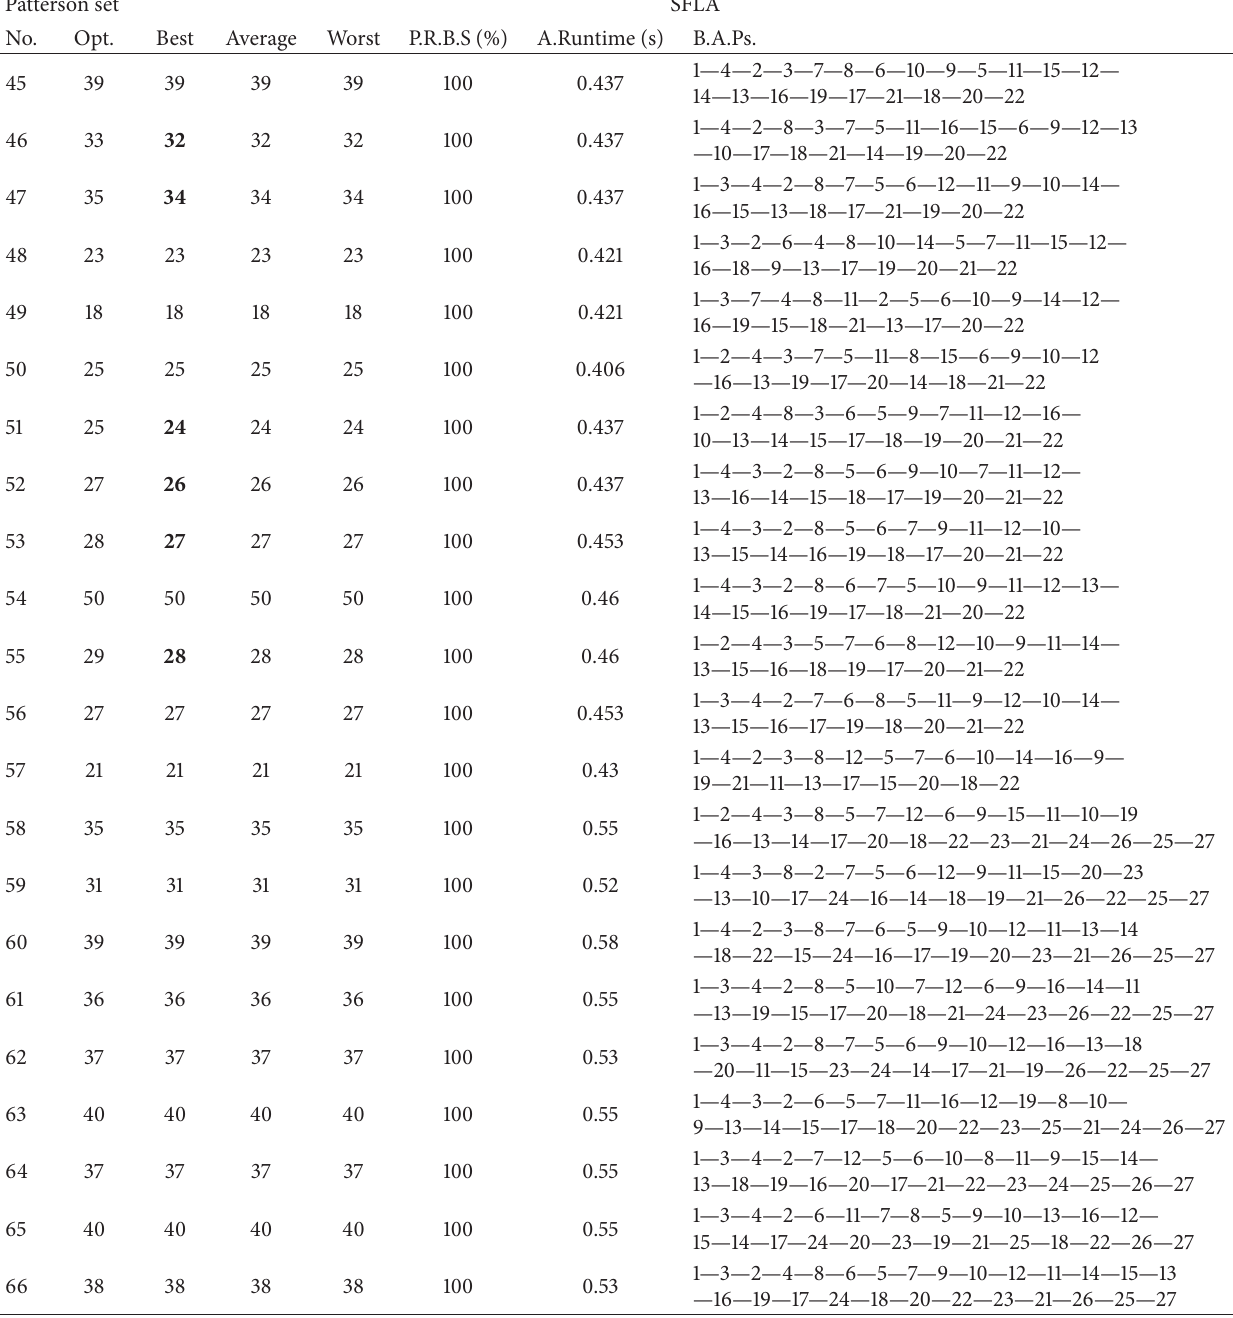
Table 3: Computational results of RCPSP PA SFLA for Patterson set